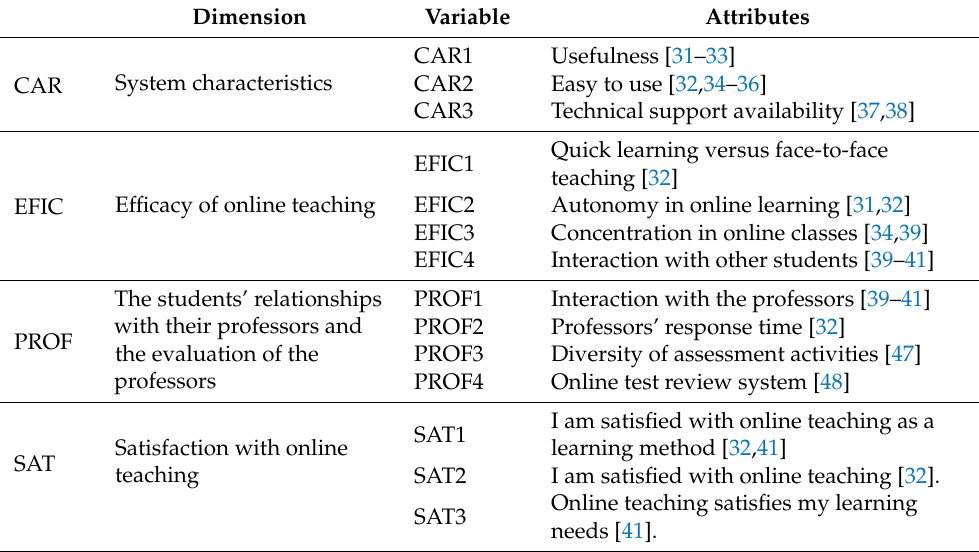
Table 1. Dimensions and attributes selected to measure quality.